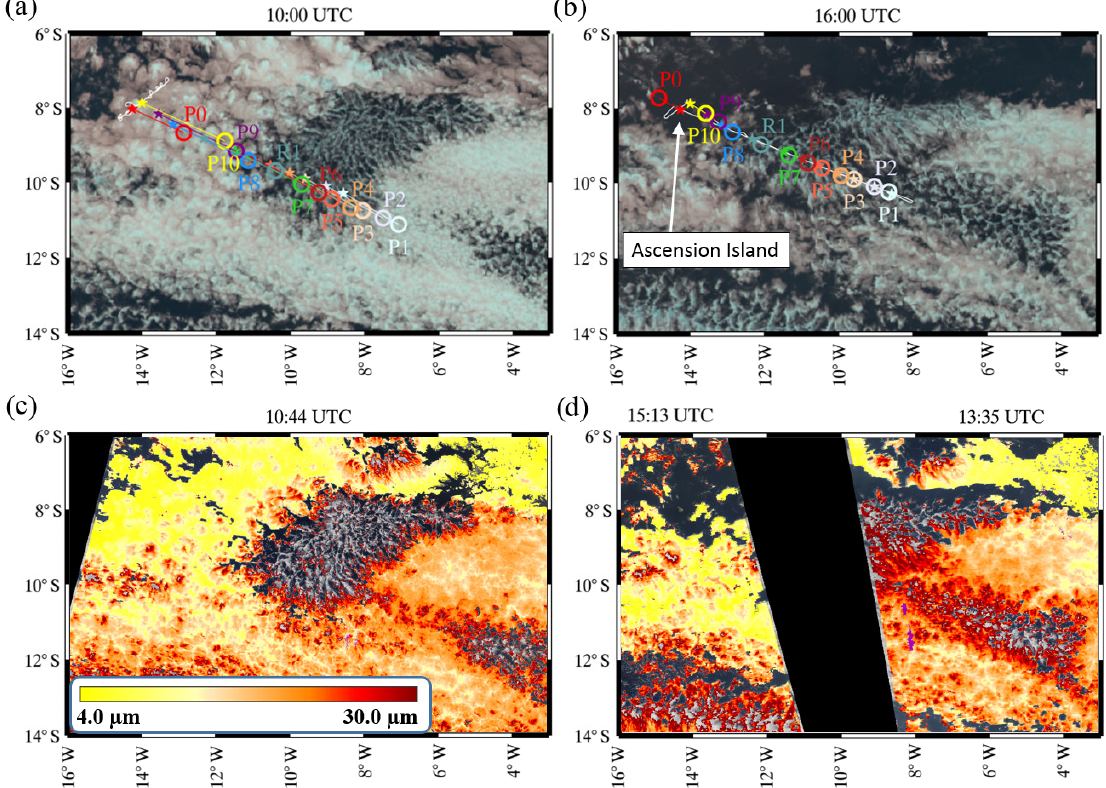
Figure 8. Panels (a, b) show SEVIRI RGB imagery at 10:00 and 16:00UTC on 5 September 2017. Aircraft tracks are shown with a thin white line from flight C051 (10:00UTC image) and flight C052 (16:00UTC image). The positions where aircraft profiles (P0 to P10) and run (R1) from flight C052 were made are shown with a star on both images. The positions of these points at the time of each satellite image as calculated from trajectories initialised at each measurement location are shown with open circles. The trajectories begin at 500m altitude and follow the boundary layer air mass. Panels (c, d) show MODIS true-colour imagery with the 3.7µm effective radius retrieval overlaid. The imagery in panels (c, d) was obtained from NASA Worldview. The overpass times are indicated at the top of each